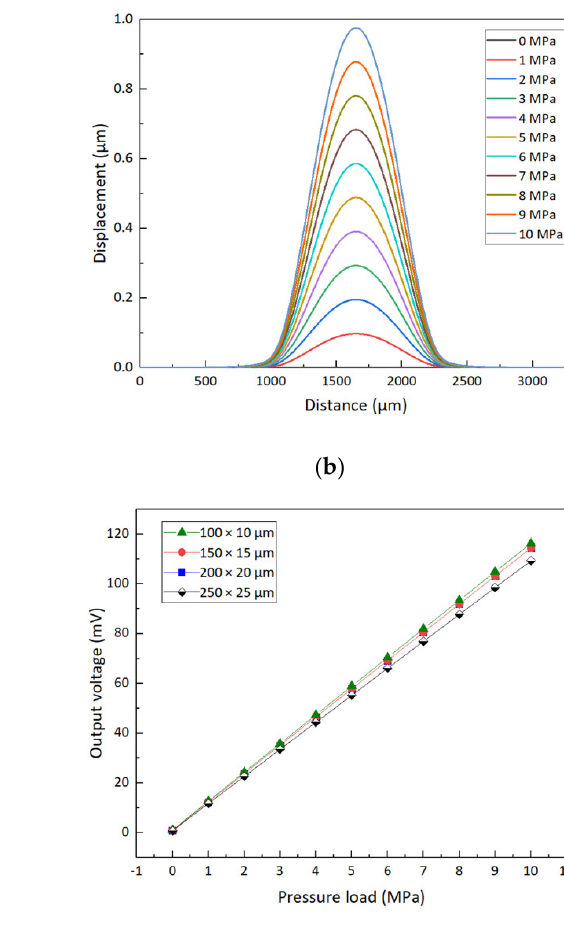
Figure 3. Coupled-field diagram of solid mechanics and electric current (single layer shell). The red arrow is the surface current density of the piezoresistors in the three small graphs on the right. 2.2. Laser Micromachining for Diaphragms In MEMS applications, the pointing stability of the laser output beam is a very vital issue for micromachining features. The laser pulse generated by the ultrafast laser oscilla- tor is utilized to meet the rigorous precision requirement. As shown in Figure 4, a laser micro-processing system equipped with a femtosecond Yb: KGW laser (Light Conversion, Pharos, Lithuania) is available for structuring bulk 4H-SiC sensor diaphragms. On-de- mand pulse operation is possible due to the existence of the laser pulse picker. The speci- fication of the laser output beam is shown in Table 1. The laser beam passing through the